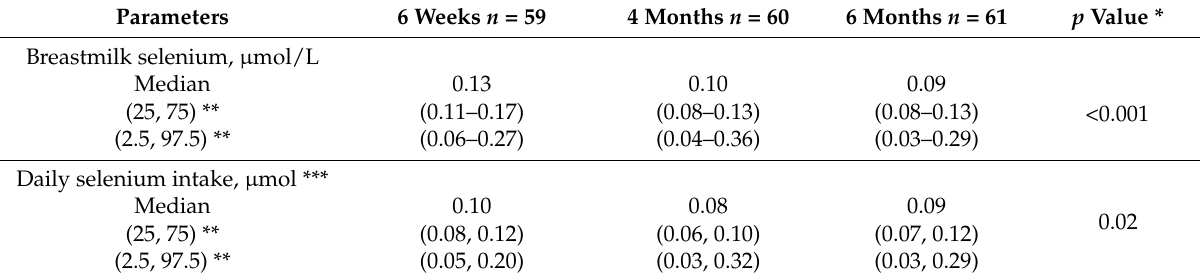
Table 4. Selenium in breastmilk and calculated infant intake at 6 weeks and 4 and 6 months postpartum.